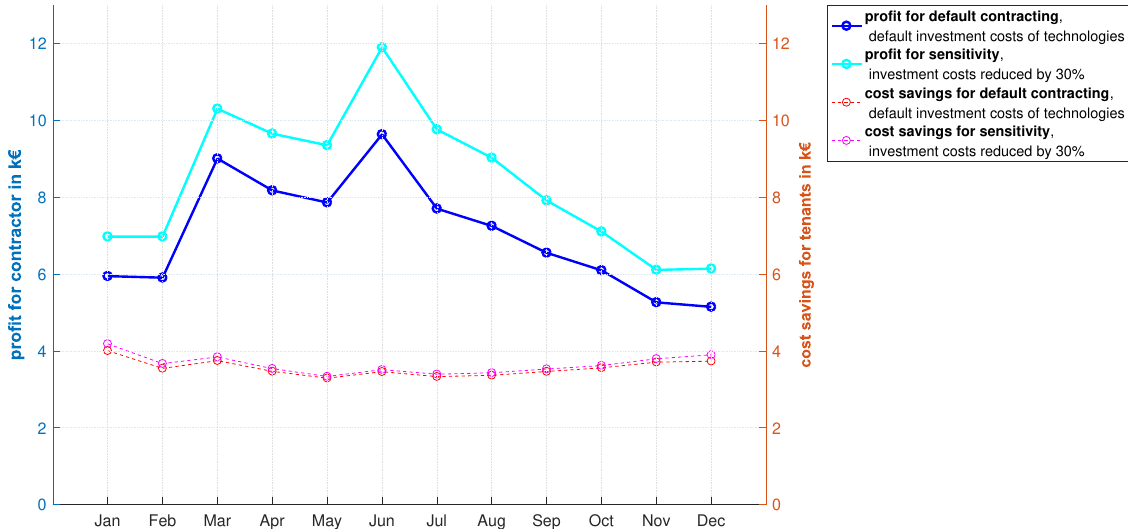
Figure 11. Comparison of monthly profit for contractor and cost savings for residents between default and 30% reduced investment costs of the local energy technologies.